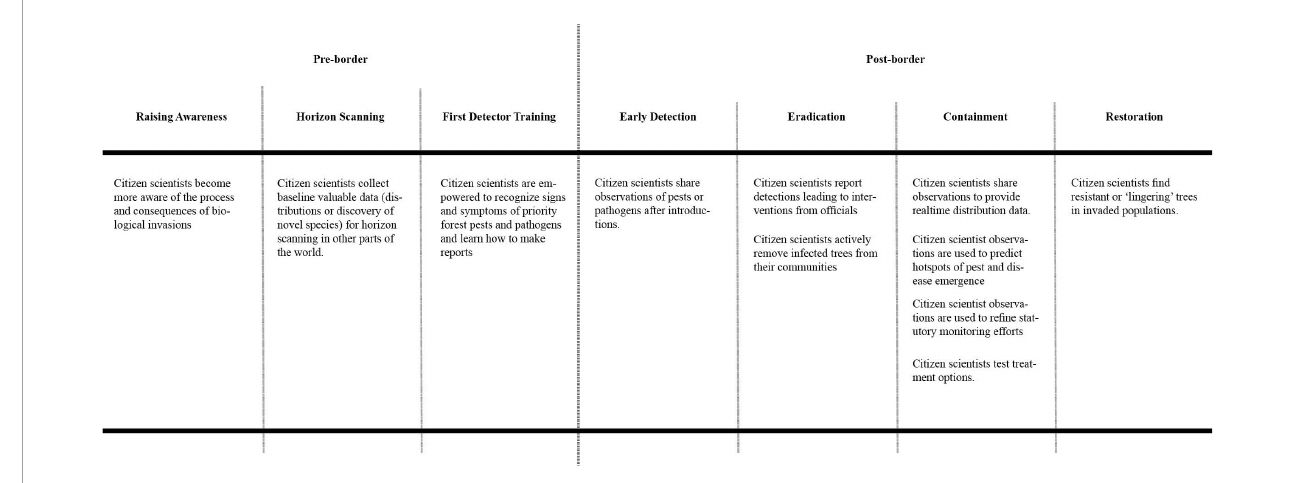
FIGURE1 Summary of the fit of the citizen science approach before and after the start of a biological